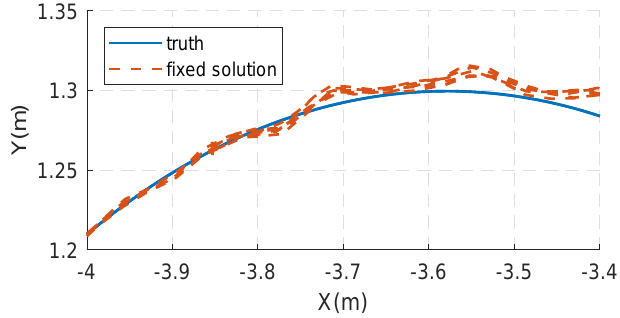
Figure 9. A partial enlargement of the horizontal positioning